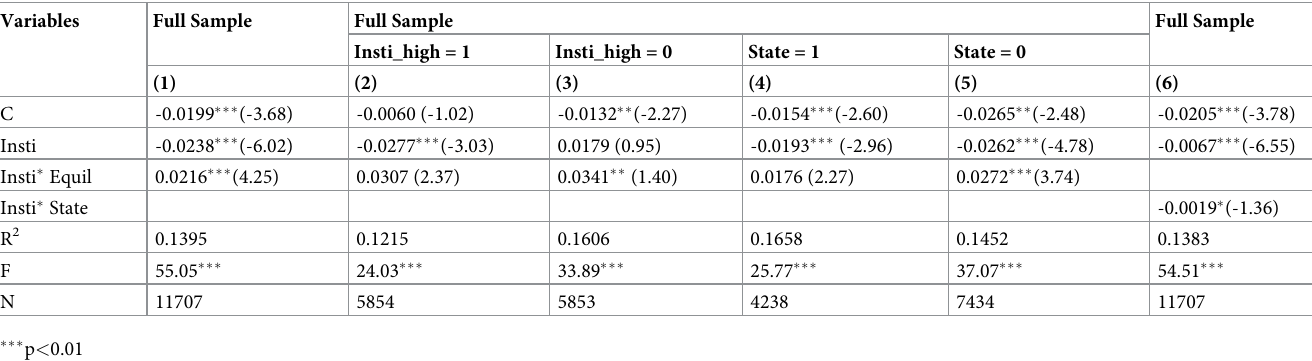
Table 6. The robustness test